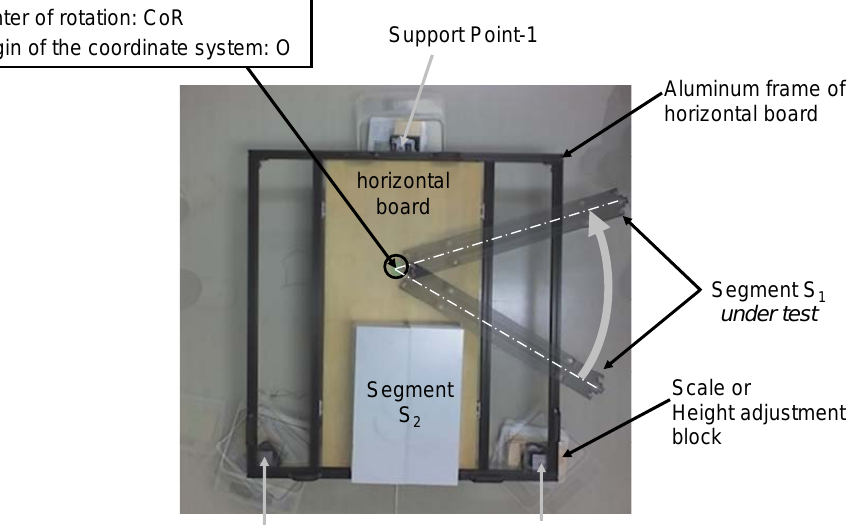
Figure 3. Overlapped pictures used in the analysis (subject: dummy mass, M : 116.3 M (1) 1